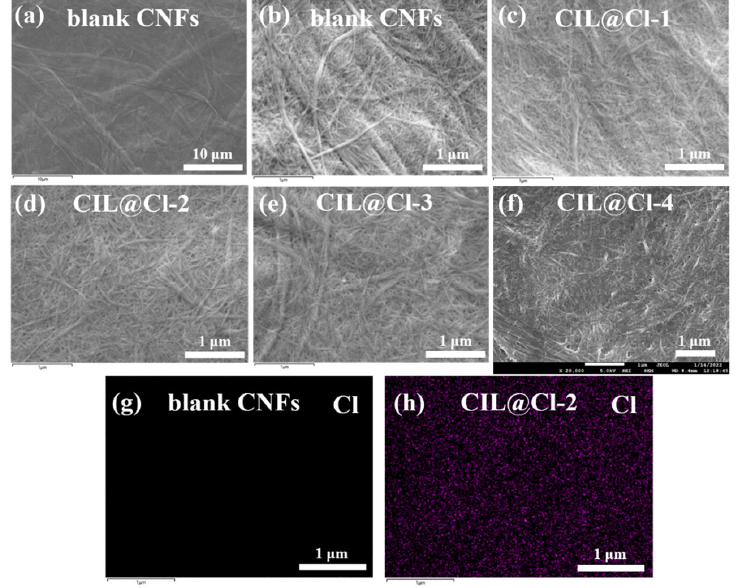
Figure 2. SEM images of ( a ) blank CNFs and high magnification SEM images of ( b ) blank CNFs, ( c )